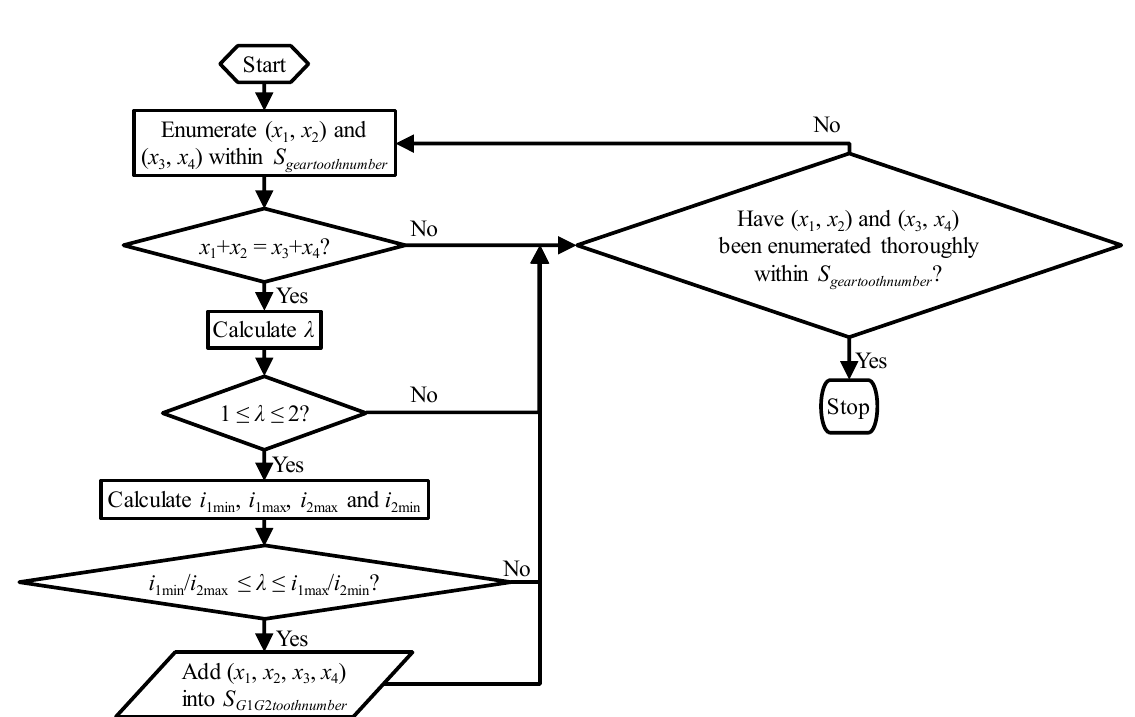
Figure 4. Scheme of the enumeration for the tooth numbers of G1 and G2.